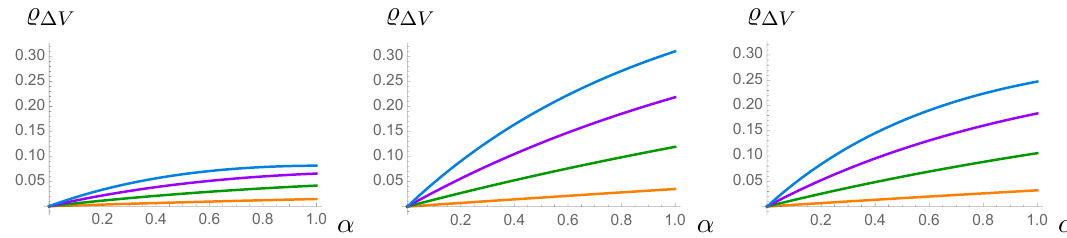
Figure 7 . Normalised back-reaction e(cid:11)ects on the scalar potential expressed in terms of the ratio % (cid:1) V de(cid:12)ned in (3.52): % (cid:1) V for the back-reaction from the in(cid:13)adron (cid:27) (left), from the in(cid:13)adron (cid:17) (middle) and from both in(cid:13)adrons (right) for the parameter choice (cid:22) = 10 (cid:21) = 10 16 GeV and (cid:20) = 0 : 25 (cid:2) 10 16 GeV (orange), 0 : 5 (cid:2) 10 16 GeV (green), 0 : 75 (cid:2) 10 16 GeV (purple), and 10 16 GeV (blue). The parameter M is parameterized through M = (cid:11) (cid:20) such that functional behaviour of % (cid:1) V on M can be evaluated over the range 0 (cid:20) M (cid:20) (cid:20) .